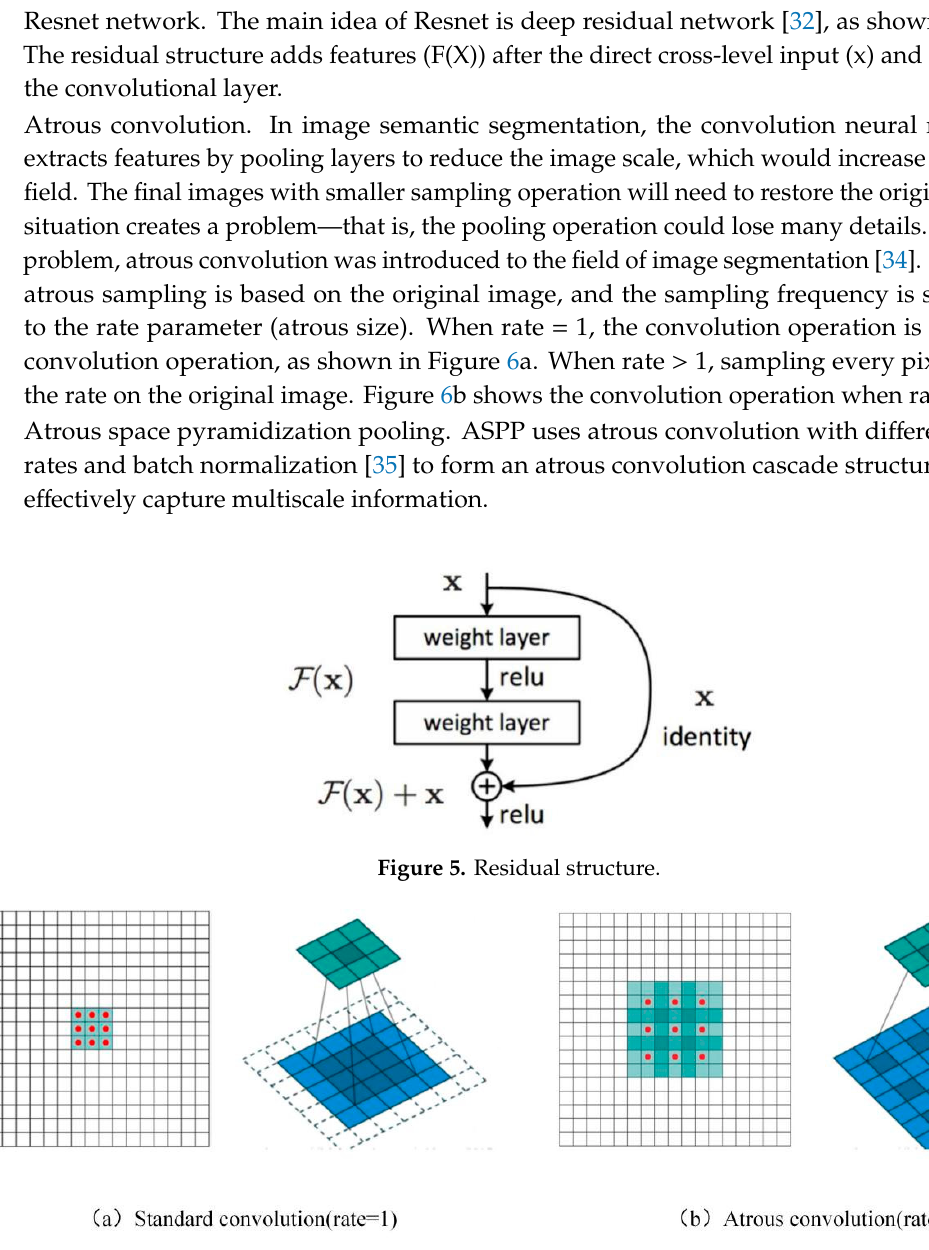
Figure 6. ( a ) Standard convolution form (rate = 1); ( b ) atrous convolution form (rate =